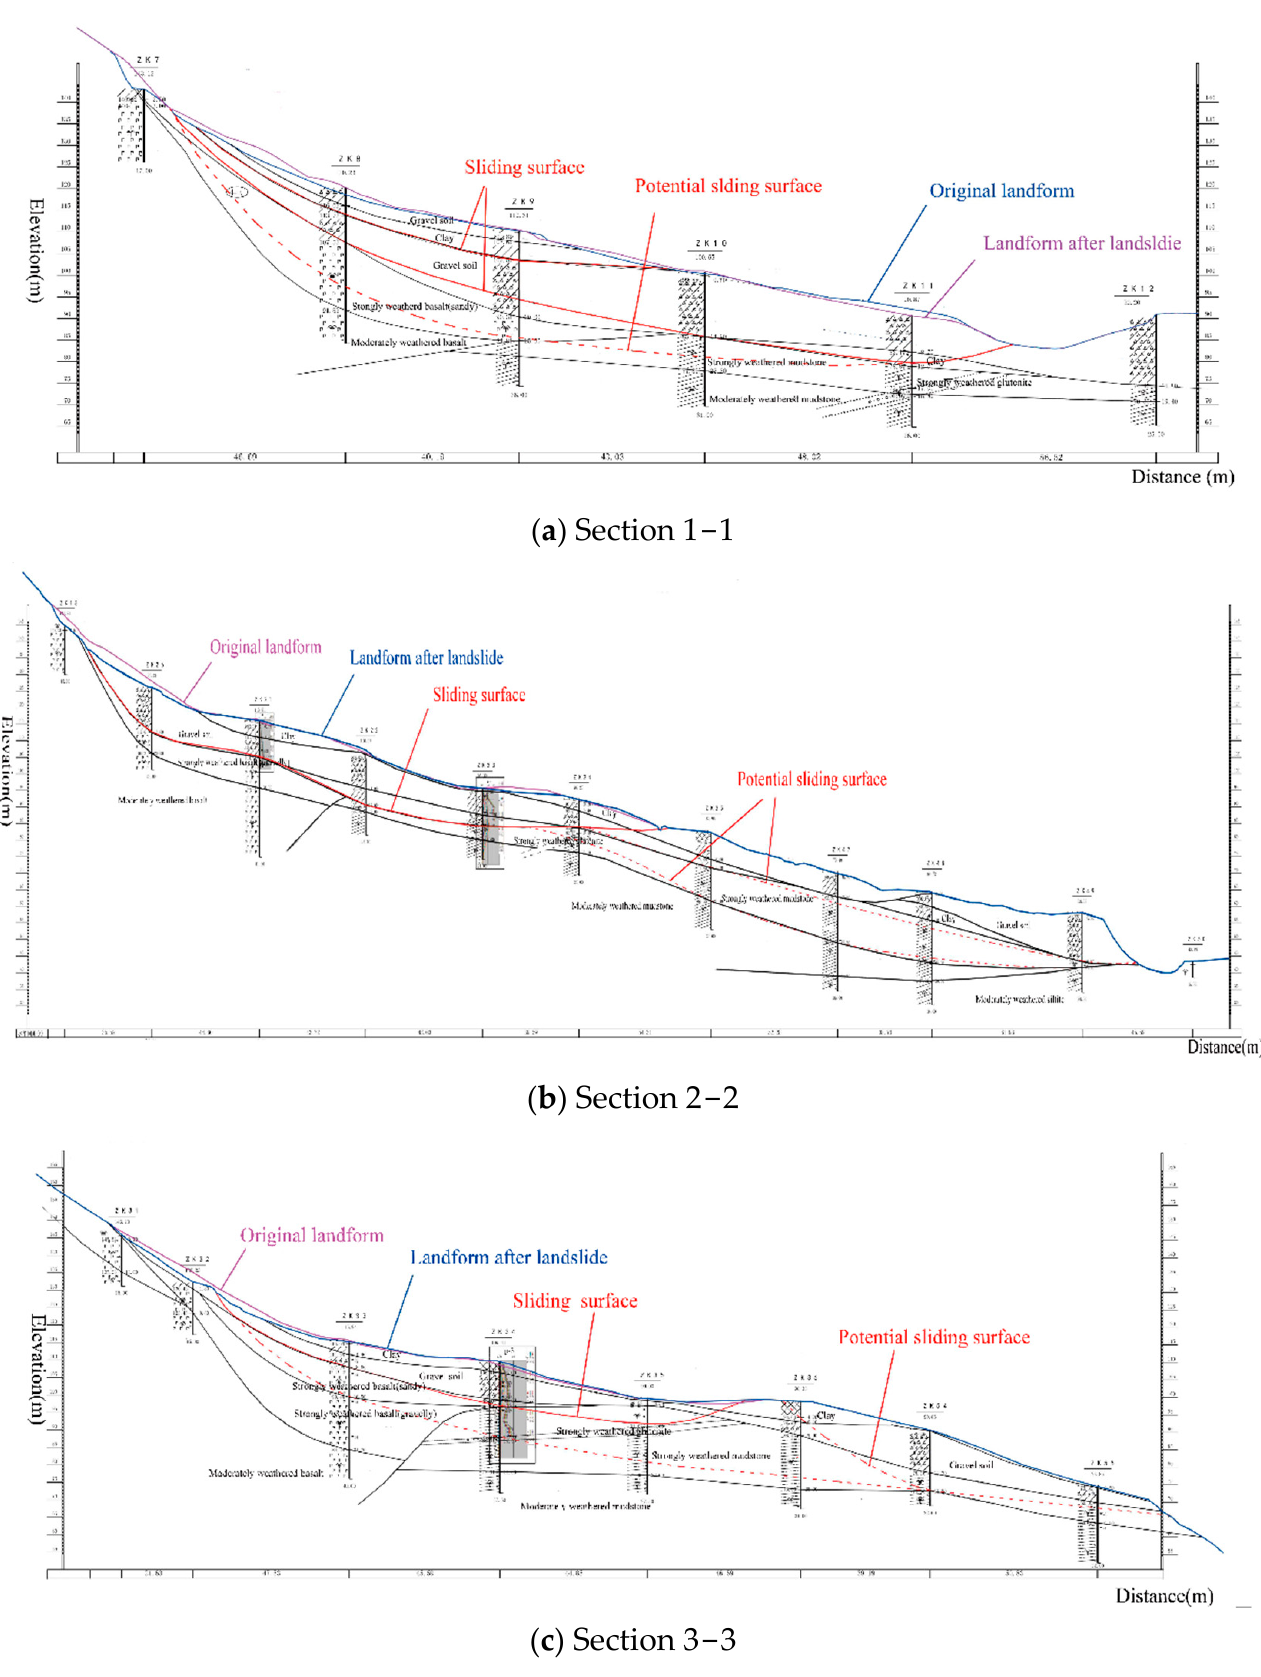
Figure 11. Geophysical profiles of the Fangshan landslide.